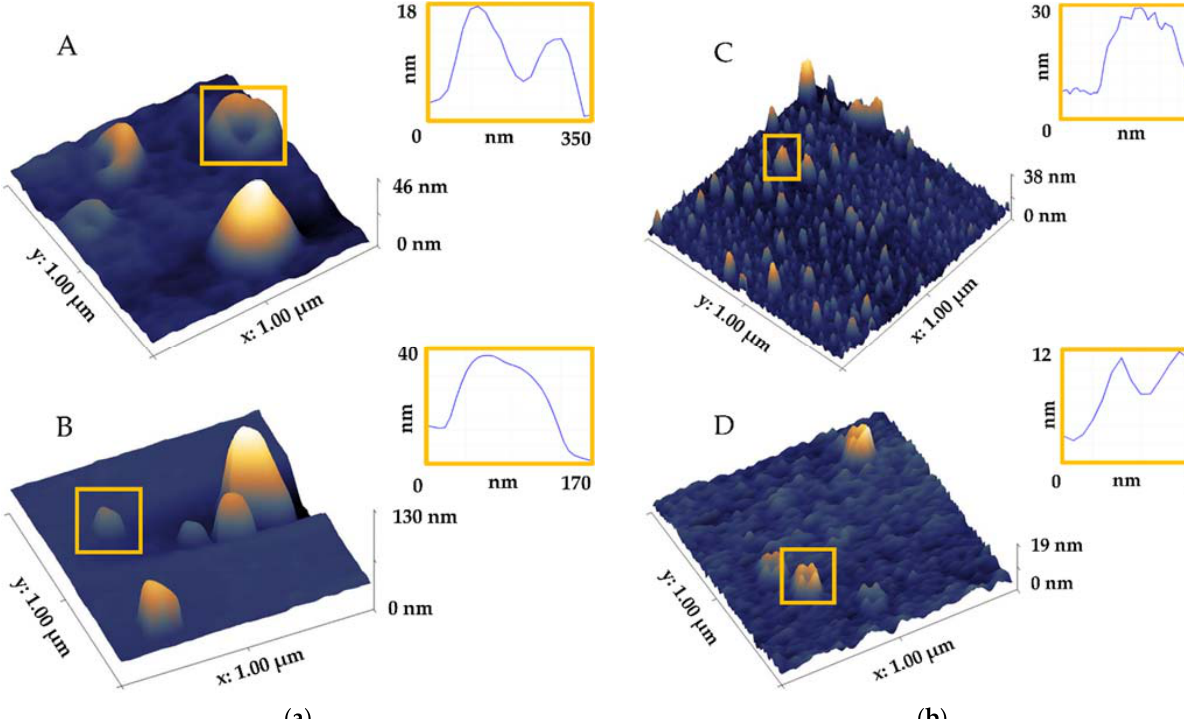
Figure 5. Tapping mode of AFM in the air ( a ) and liquid ( b ) environments for imaging of native CSF ( A , C ) and EVs isolated by SEC ( B , D ) with selected profiles of EV-like structures. ( A , B ): sample fixed with PFA, on mica, analysed using MFP-3D (Asylium Research) with OMCL/TR400PSA-HW (Olympus) probe; ( C ): sample on mica, analysed using Dimension Icon (Bruker) with ScanAsyst (Bruker) probe; ( D ): sample on a glass coverslip, RCA cleaned and activated with oxygen plasma, analysed using Nanowizard II (JPK Instruments) with MLCT (Bruker Nano) probe, with photothermal excitation.